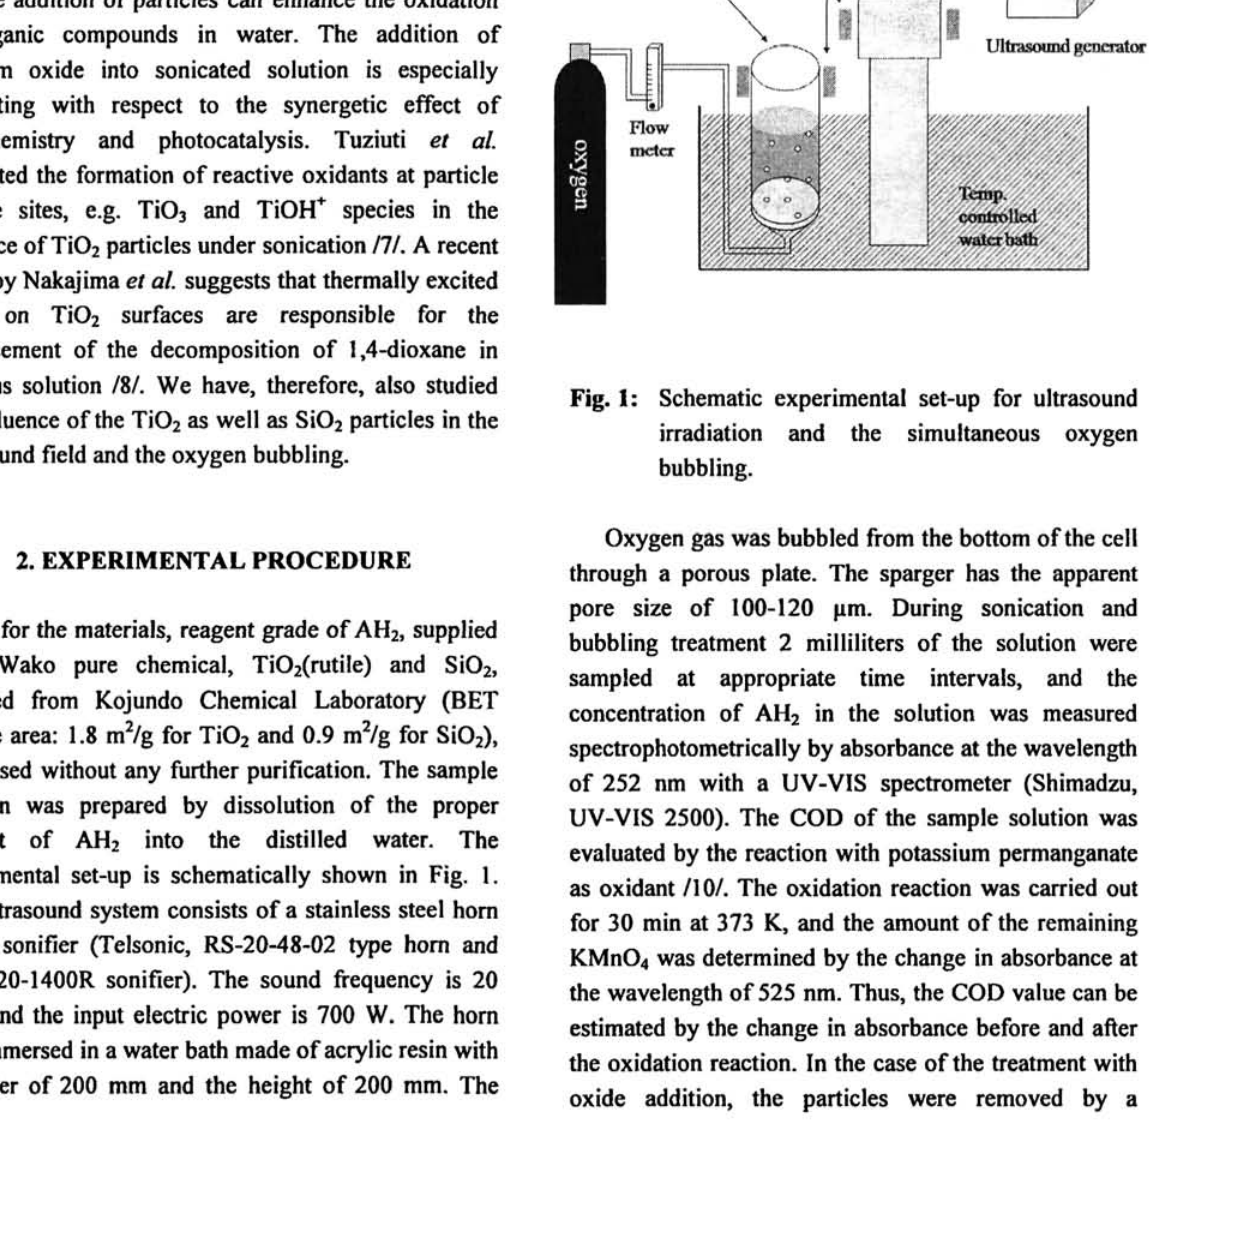
Fig. 1: Schematic experimental set-up for ultrasound irradiation and the simultaneous oxygen